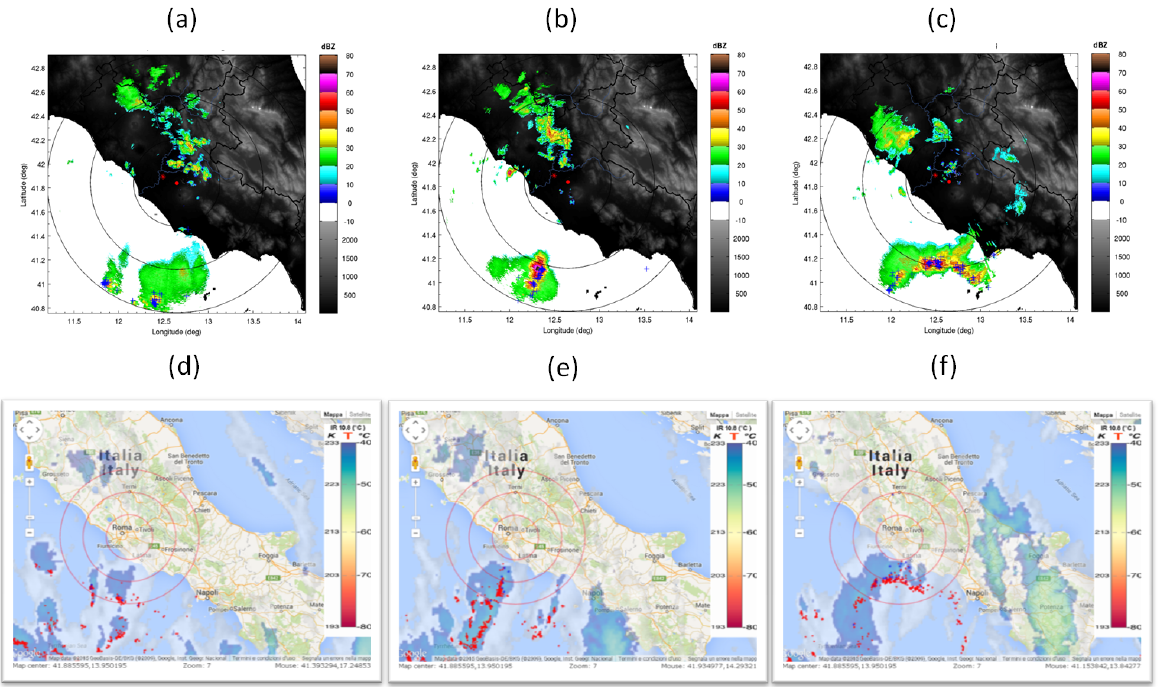
Figure 3. Polar 55C Z h (1.6 ◦ of elevation angle) at 20:00UTC (a) , 21:00UTC (b) , and 22:30UTC (c) on 13 September 2012. The strokes registered in 5min are superimposed (blue cross). In (d–f) panels, the corresponding infrared (IR) MSG images at 10.8µm are shown with the LINET strokes that occurred in 15min (CG in red dots; IC in blue dots) and Polar 55C range rings at 40, 80, and 120km ( d–f panels were generated using the MAMS tool developed at ISAC-CNR, Petracca et al., 2013).